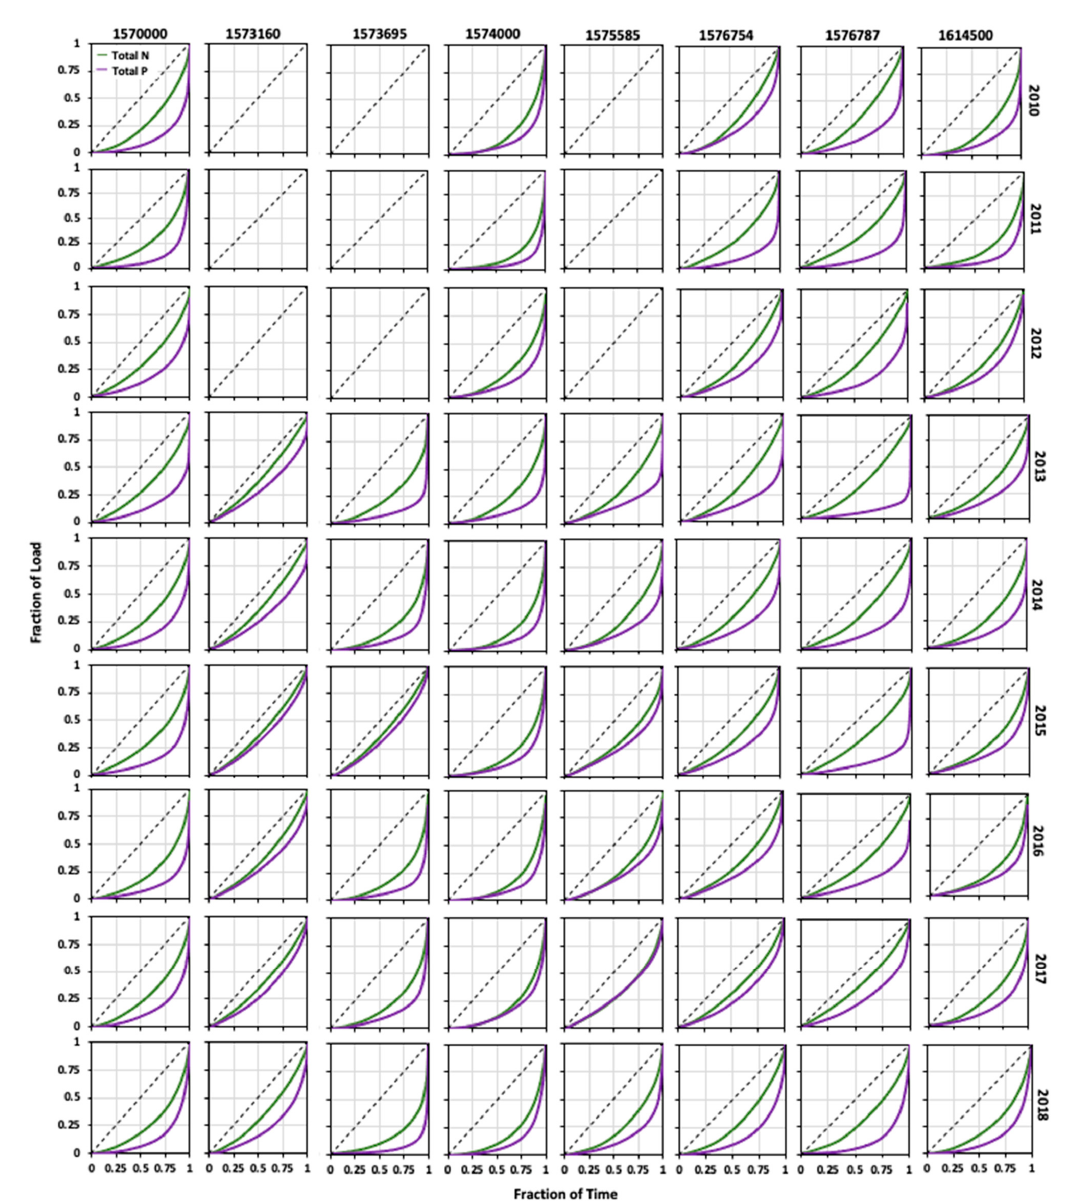
Figure 3. Lorenz Curves for total nitrogen (TN) and total phosphorus (TP) loads exported for each year for each selected study site. The dotted line represents the “Line of Equality”, with temporal inequality signified by the degree to which the Lorenz Curve plots below the line. Blank plots are shown when no load data are available for those years for specific gauging stations. Table 3. Gini Coefficients for total nitrogen ( G TN ) and total phosphorus ( G TP ) loads exported for each year for each selected study site, along with percentages of time that each load is exported during low- and high-flow conditions.